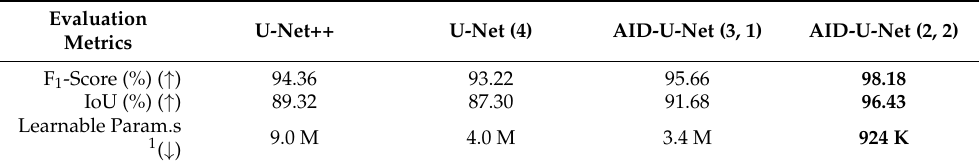
Table 5. Comparative results between U-Net with depth 4, AID-U-Net (3, 1) and AID-U-Net (2, 2) applied to microscopic image segmentation.